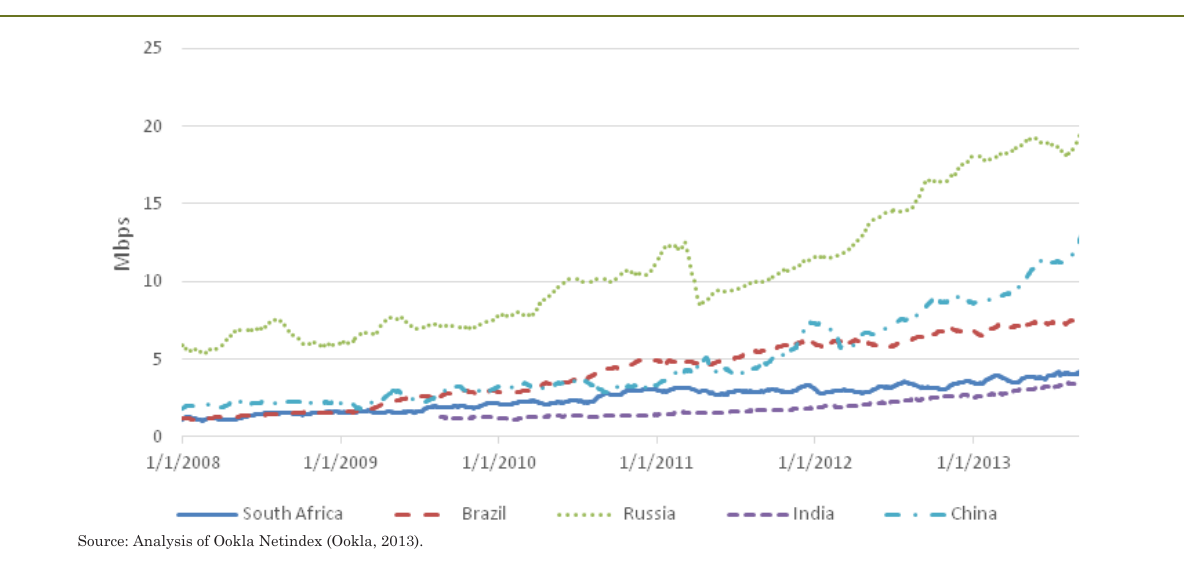
FIGURE 5: BROADBAND SPEEDS IN BRAZIL, RUSSIA, INDIA, CHINA AND SOUTH AFRICA (2008-2013)